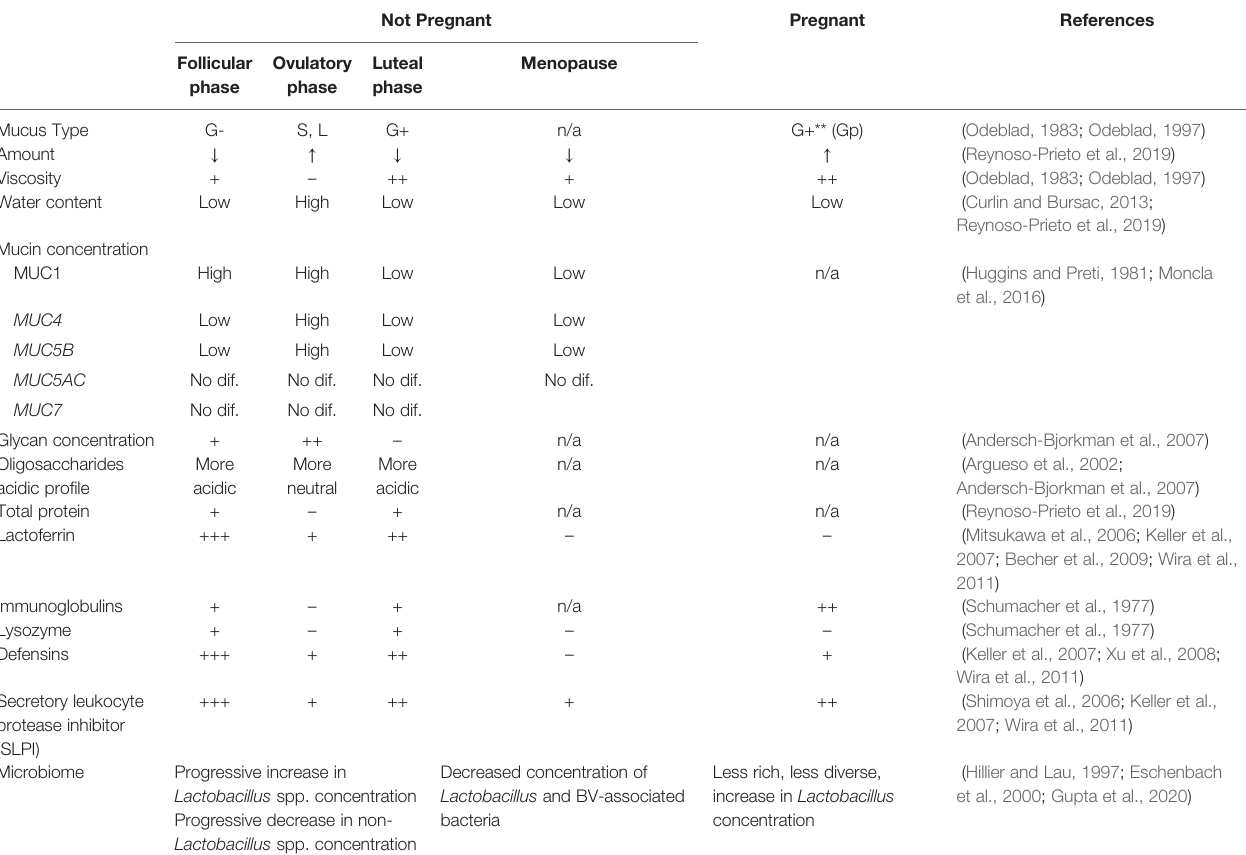
TABLE 1 | Changes in cervicovaginal mucus properties and microbiome across menstrual phases and signi fi cant hormonal changes with menopause or